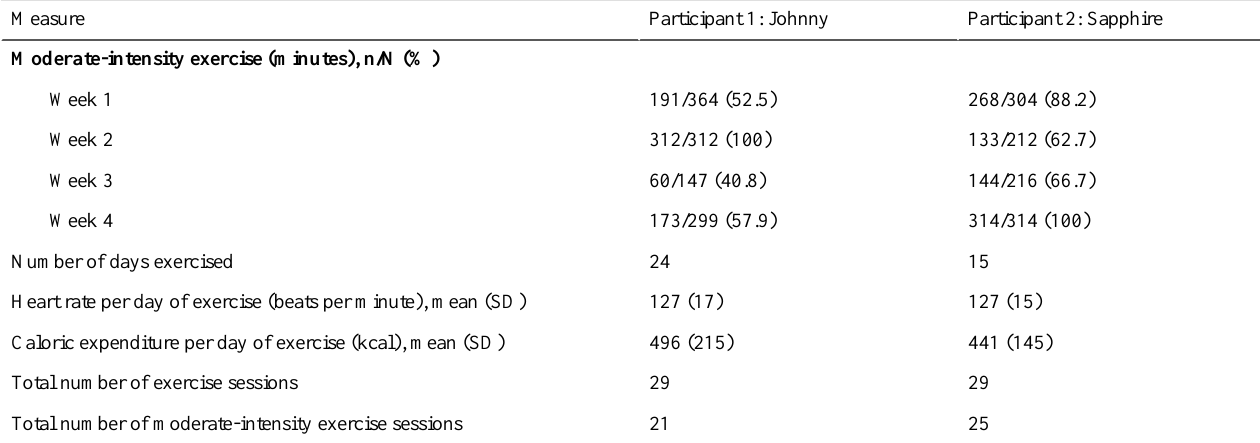
Participant 2: SapphireParticipant 1: JohnnyMeasure